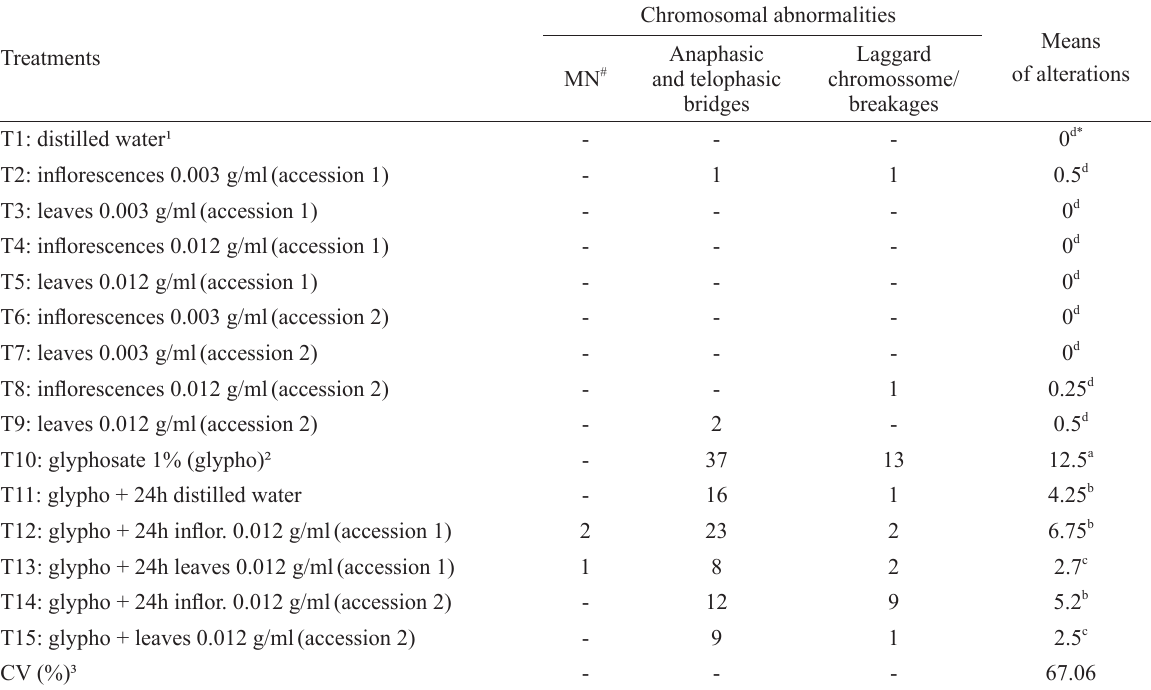
Number, types and means of chromosomal abnormalities in Allium cepa root tips cells for each treatment. Treatments